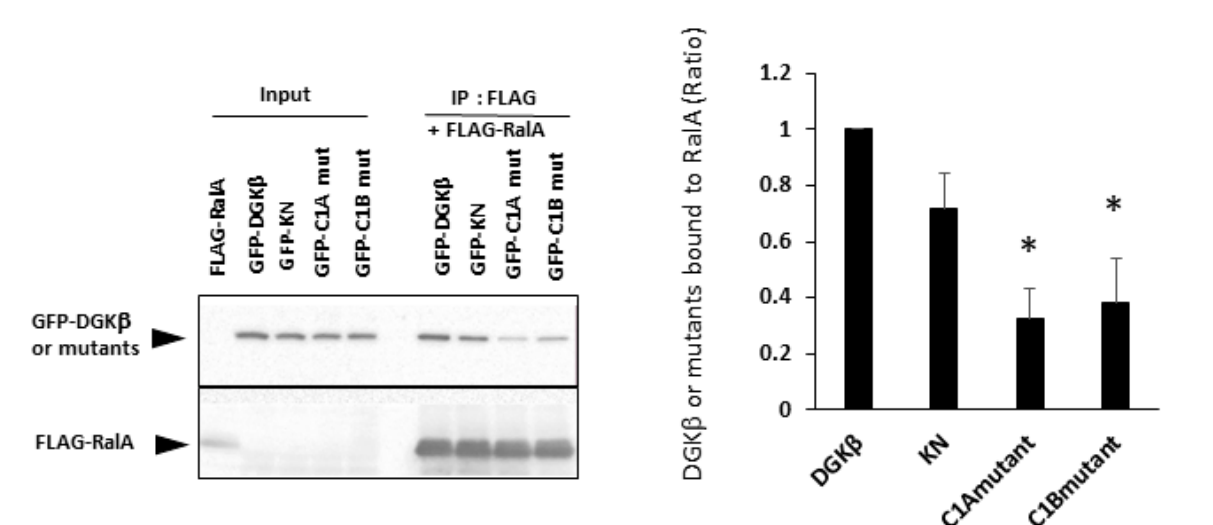
Figure 2. Binding of RalA to DGK β via the C1 domain. Pull down assay was performed using COS-7 cells separately overexpressing FLAG-RalA and GFP-DGK β , GFP-DGK β KN, C1A or C1B mutants. Three independent experiments were performed. The mean and SEM of density of bands are shown as ratio to the wild type (WT) DGK β . * p < 0.05 followed by Student’s t -test (vs. GFP-DGK β ).